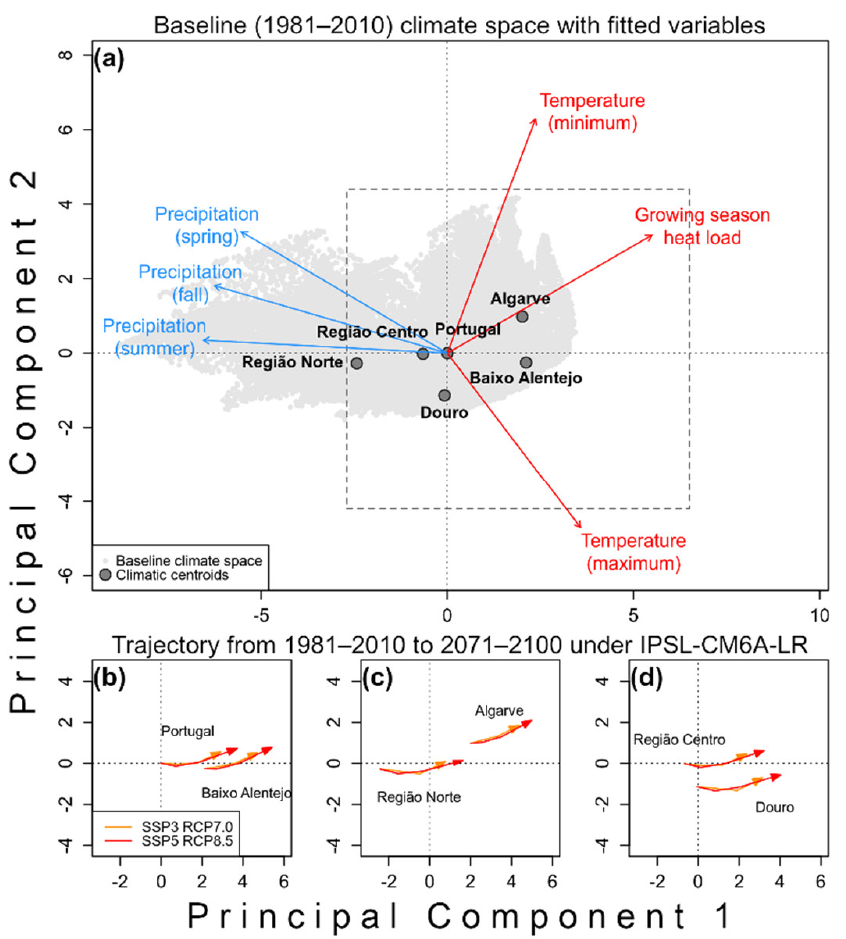
Figure 1. Ordination plots of Portugal in climate space comprising six variables: precipitation in spring, summer, and fall, temperature extremes (min. and max.), and growing season heat load; ( a ) the arrows and light gray points represent fitted vectors of precipitation (blue) and heat (red) and the entire baseline climate space, respectively, while the filled circles represent regional centroids; ( b – d ) climatic trajectories under climate change following SSP3-7.0 (orange) and SSP5-8.5 (red).